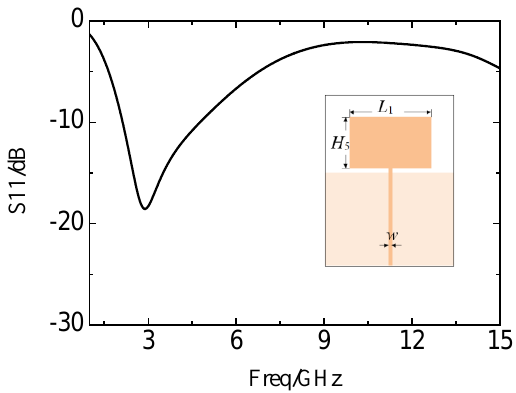
Figure 4. Simulation results of the reflection coefficient of the rectangular microstrip patch antenna.